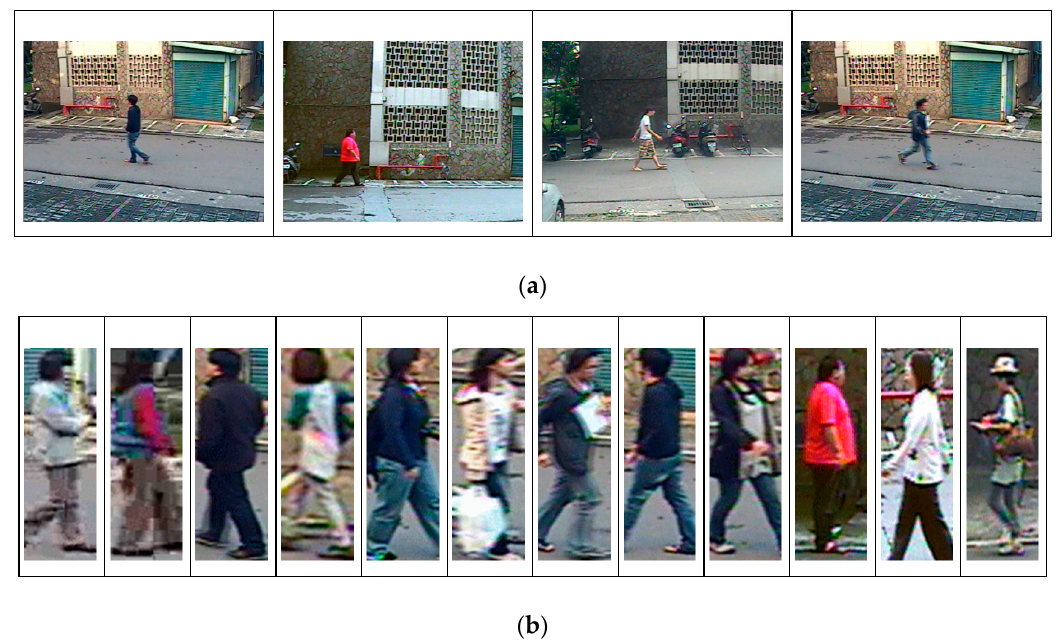
Figure 5 . Training videos scenes. ( a ) Training videos and ( b ) moving objects in training videos.